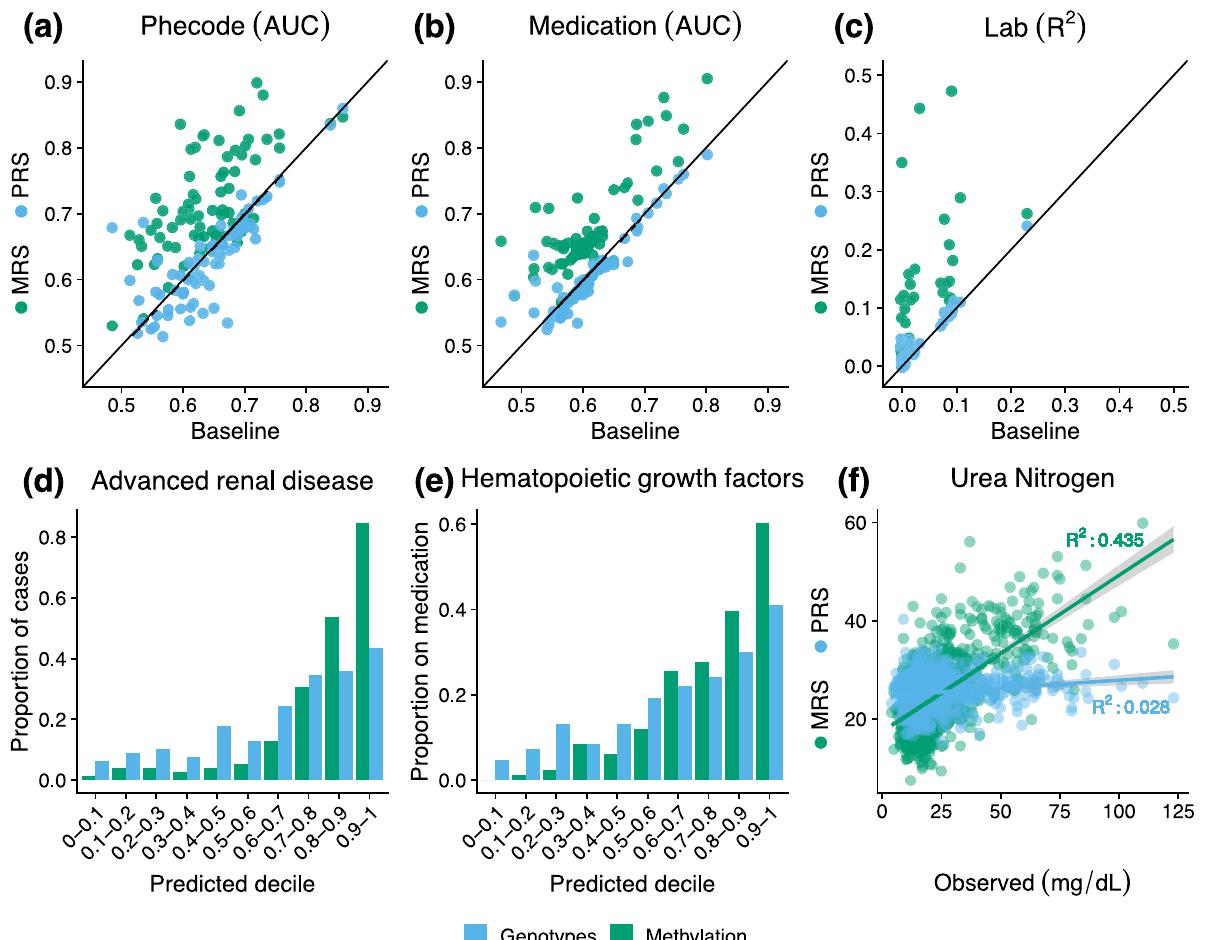
Fig. 1 MRS increases imputation accuracy on a variety of outcomes. a – c The performance of the PRS (blue) and MRS (green) imputations on the y-axis with the baseline model performance on the x-axis. The performance of binary phenotypes (Phecodes ( a ), medications ( b )) is measured using area under the ROC curve (AUC) and the performance of continuous phenotypes (lab results ( c )) is measured using proportion of variance explained ( R 2 ). Shown is the performance on the union of outcomes that were signi fi cantly improved over the baseline model by either the MRS or PRS and that were signi fi cantly imputed by their corresponding predictor (72 Phecodes, 59 medications, and 31 labs). d – f The disease incidence as a function of the PRS (blue) and MRS (green) binned by deciles ( d , e ); and the observed Urea Nitrogen lab result value plotted against its imputed value ( f